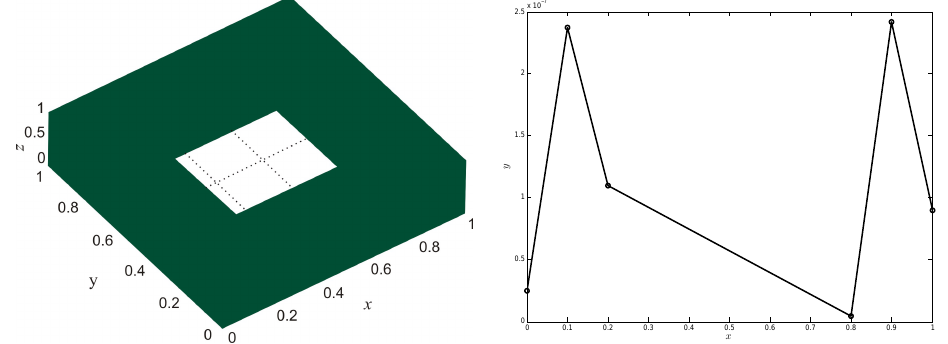
Figure 11. A three-dimensional computational domain for Problem 5.